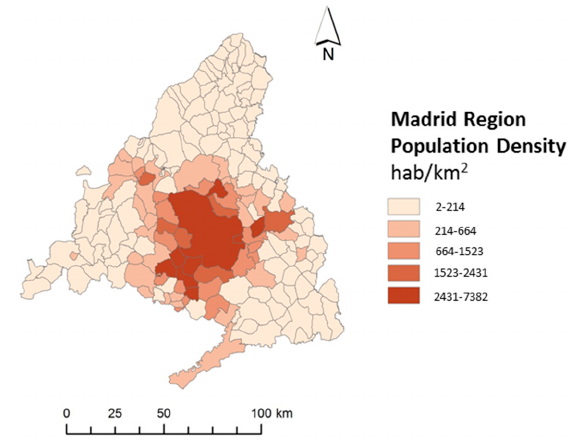
Figure 2. Population density by municipality in the Madrid Region.